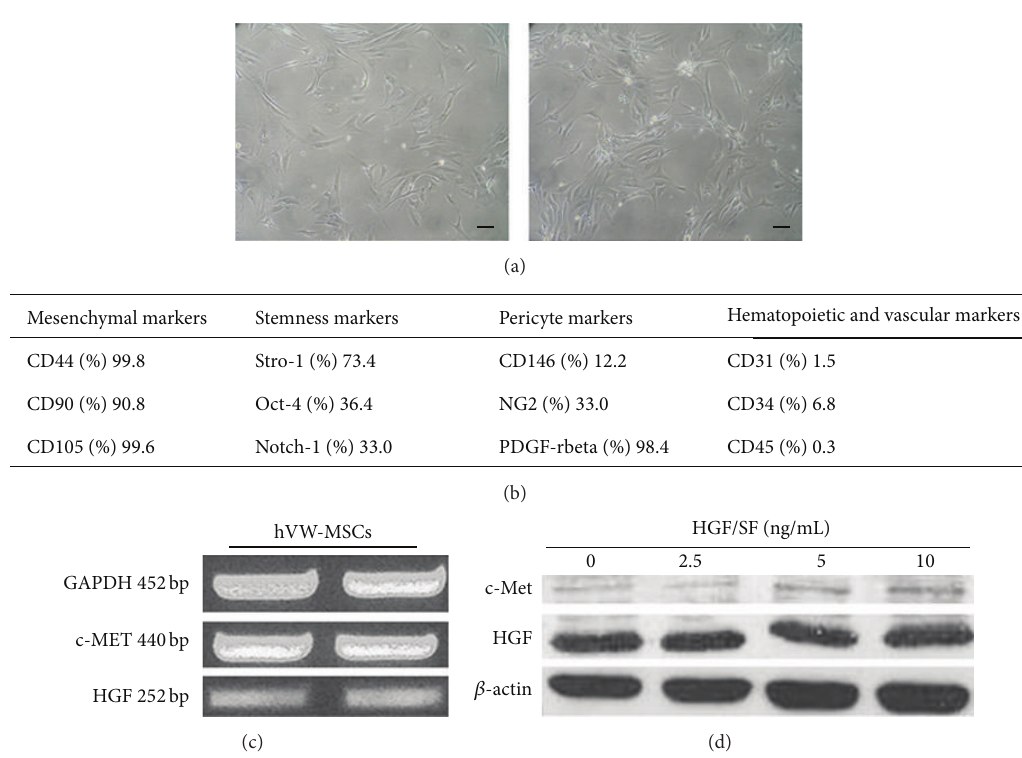
Figure 1: hVW-MSC aspect and HGF/ c-MET expression. (a) hVW-MSCs were enzymatically isolated from human arteries and, at passage 3, they exhibited adherence to the plastic substrate and a typical spindle-shaped morphology. Scale bars = 100 𝜇 m. (b) Flow cytometry analysis of mesenchymal, stemness, pericyte, and hematopoietic and vascular markers expressed in our cell model of hVW-MSCs. Values are reported in percentage of positivity. (c) Basal expression of HGF (252 bp) and c-MET (440 bp) mRNA in hVW-MSCs, detected by RT-PCR. (d) c-Met and HGF protein detection on cell lysates of hVW-MSCs exposed to HGF/SF (0, 2.5, 5, and 10ng/mL) for